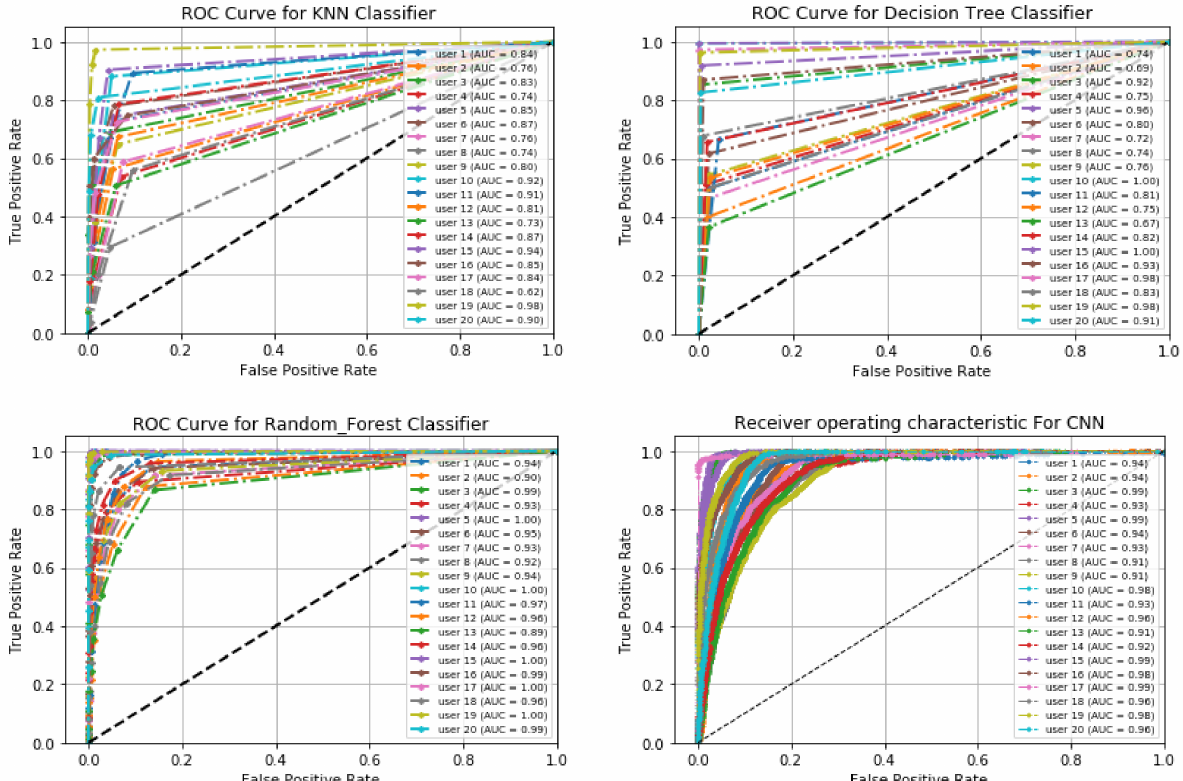
Figure 13. ROC curves for continuous authentication—single point-and-click